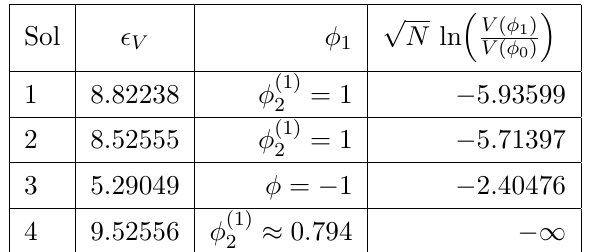
p N ln V ( (cid:30) 1 ) for the cases presented in the tables of appendix A of [82]. V ( (cid:30) 0 )